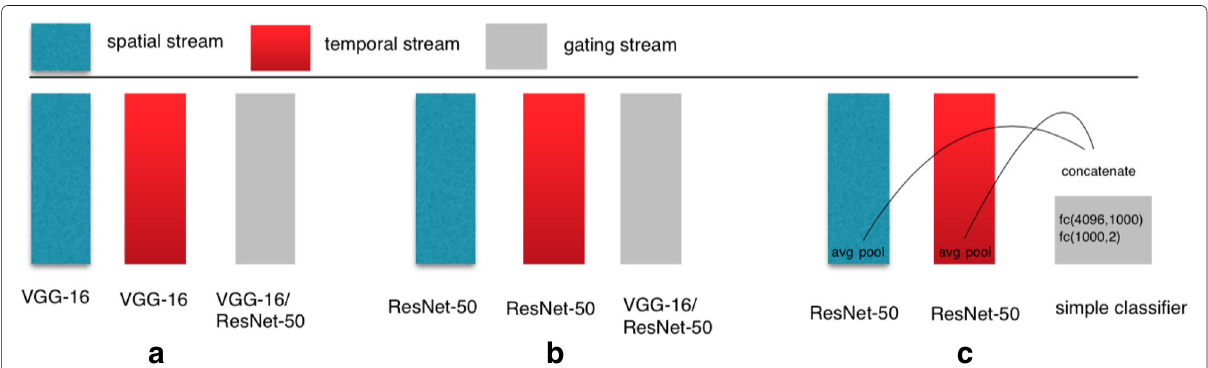
Fig. 3 Various combinations of expert-gating CNNs. a VGG-16s as the experts & VGG-16/ResNet-50 as the gating. b ResNet-50s as the experts & VGG-16/ResNet-50 as the gating. c ResNet-50s as the experts & a simple classifier as the